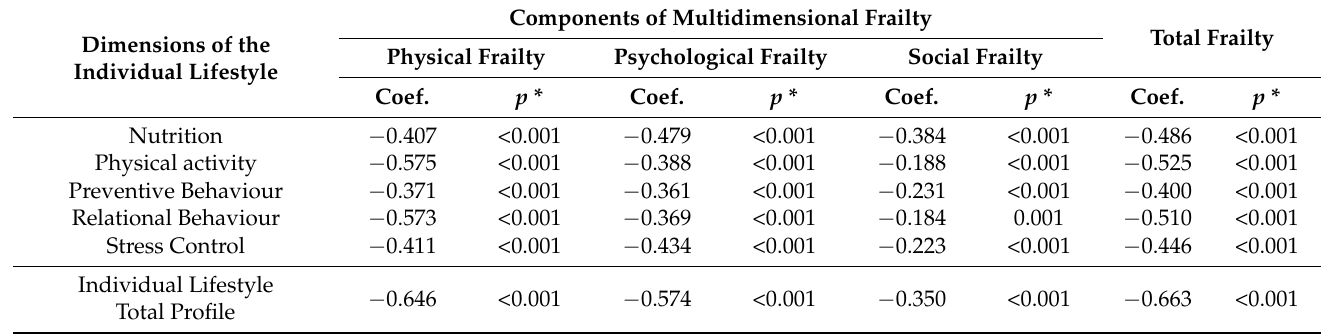
Table 5. Correlations between dimensions of the individual lifestyle profile and physical, psychologi- cal, social, and total frailty from the